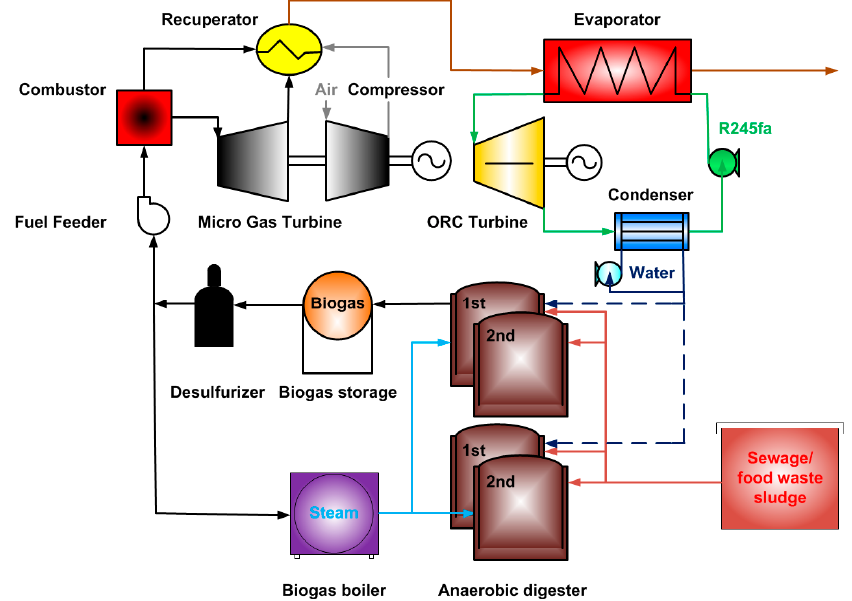
Figure 1. Schematic diagram of a biogas-fuelled micro-gas turbine with a bottoming organic Rankine cycle power system. cycle power